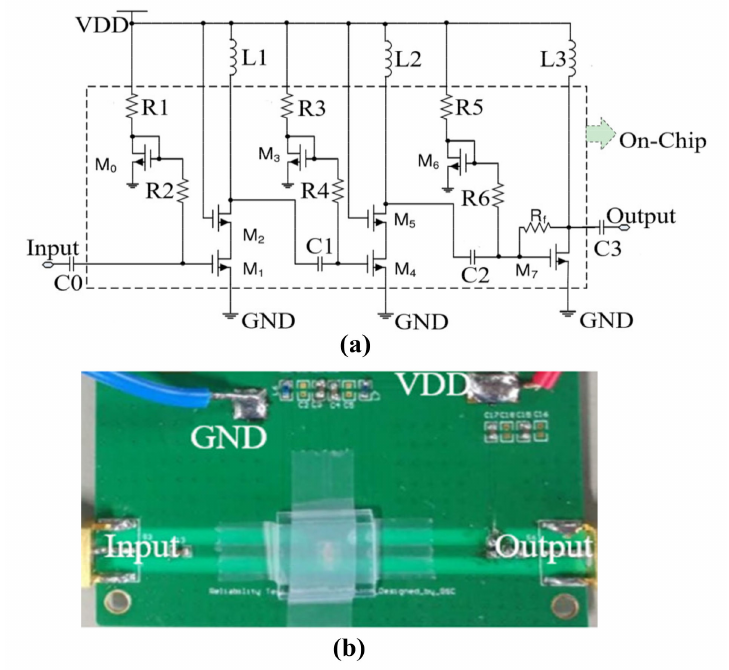
Figure 1. The 0.3–1.1 GHz CMOS PA: ( a ) The detailed schematic diagram; ( b ) the physical